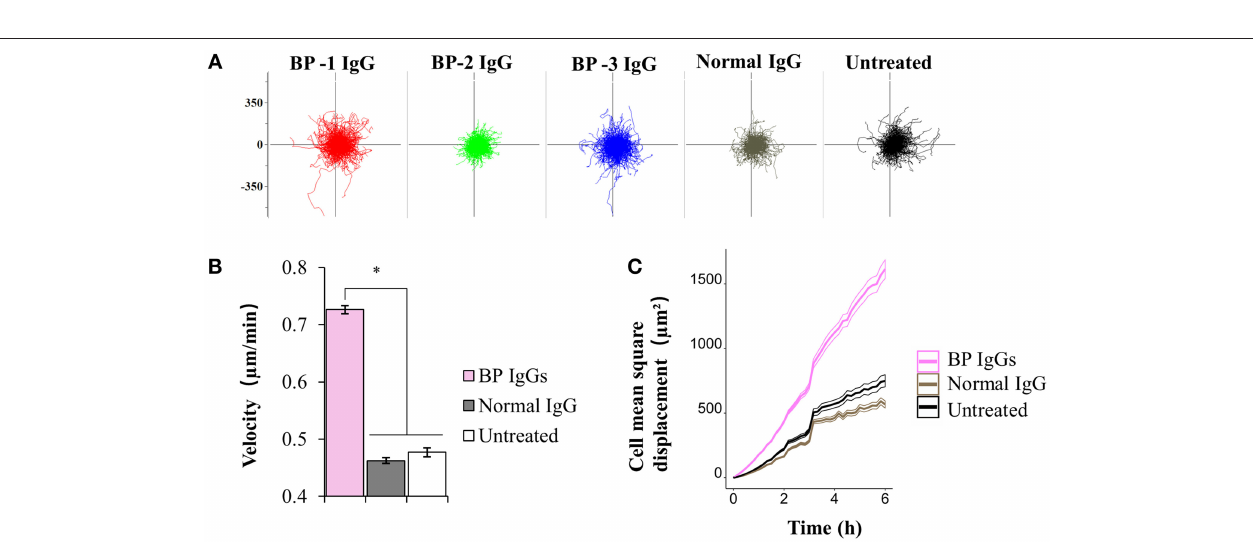
FIGURE 8 | Results of the cell motility assay using NHEKs stimulated with BP IgG. Hoechst 33342-labeled NHEKs were incubated with IgGs obtained from 3 patients with BP (BP-1, BP-2, and BP-3) or normal IgG, and imaged using time-lapse microscopy. Images were captured at 10min intervals for up to 6h. (A) Migration displacement maps were generated by centering the cell migration paths at a common starting point. Axes of vector diagrams = 500 µ m. (B) Cell velocity of NHEKs treated with IgGs. One-way ANOVA was employed to determine the significance of differences induced by BP IgGs. * p -value < 0.05. (C) Mean square displacement of the NHEKs treated with